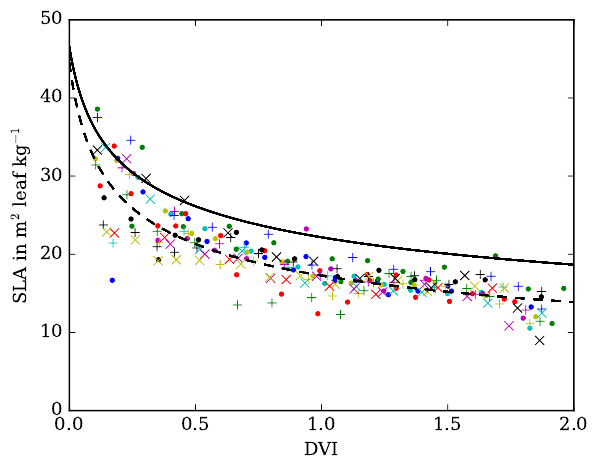
Figure 6. Specific leaf area against DVI. Dots, vertical crosses (+) and diagonal crosses (x) are US-Ne1, US-Ne2 and US-Ne3 ob- servations respectively. Solid line shows the fit using parameters from Osborne et al. (2015) ( γ = 22 . 5, δ = − 0 . 2587) and dashed line shows a tuned fit ( γ = 17 . 6, δ = − 0 . 33).